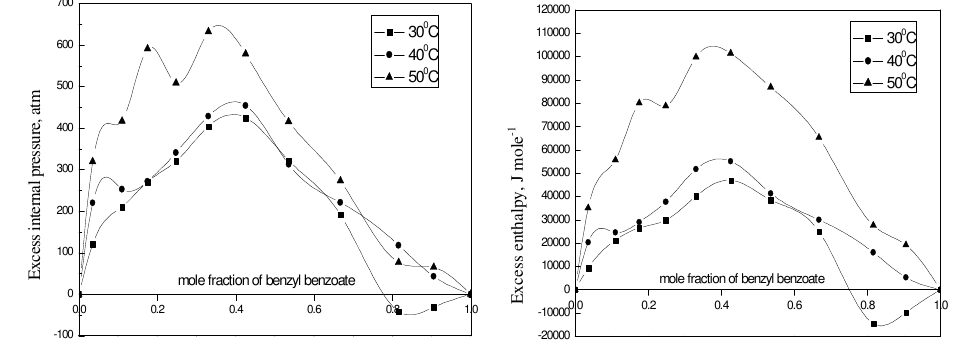
Mole fraction of benzyl benzoate